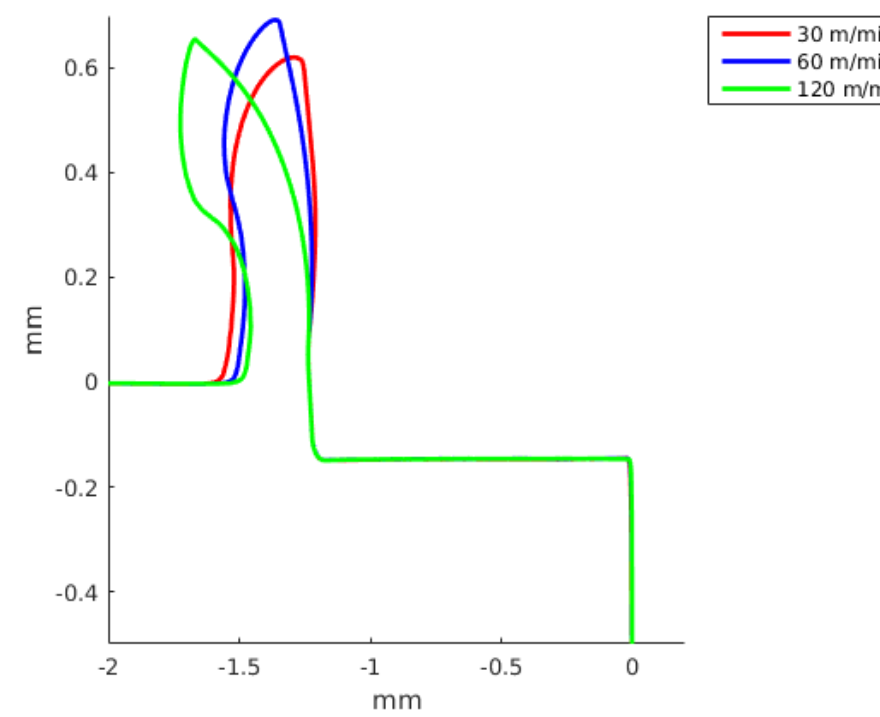
Figure 13. Predicted chip shape at different cutting speeds using Johnson-Cook model and material properties 7 (see Table 1). Feed of 0.15